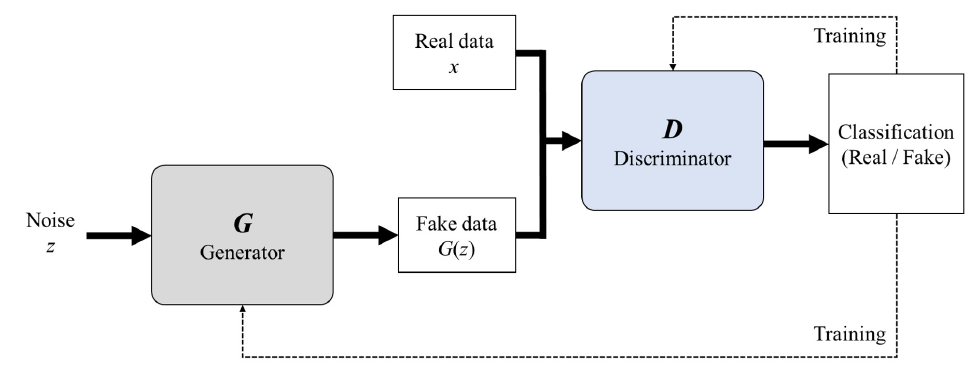
Figure 4. Schematic of the GAN.